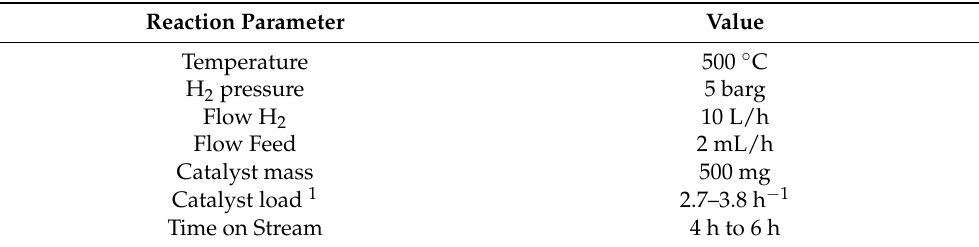
Table A1. Standard reaction parameters of catalytic experiments.